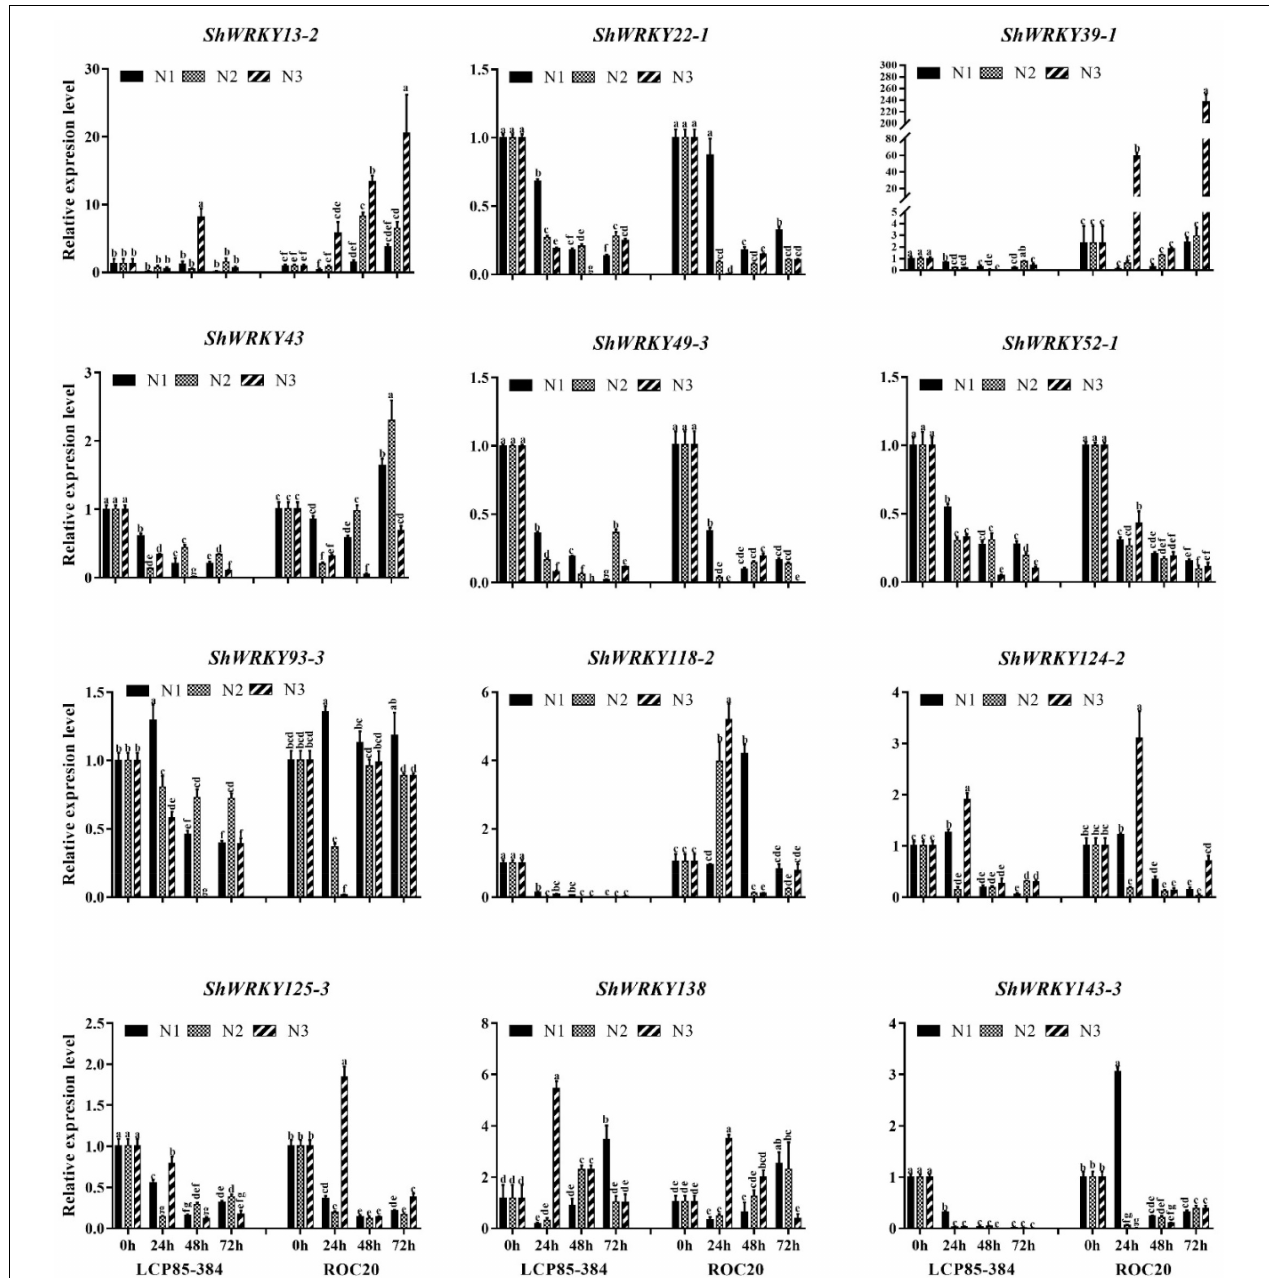
FIGURE 6 | Expression profiling of twelve ShWRKY genes at different times after nitrogen implantation dosage in LCP85-384 and ROC20 cultivars. Values are means ± standard errors. Means having the same letters above the vertical bars are not significantly different at a 5% level of probability.